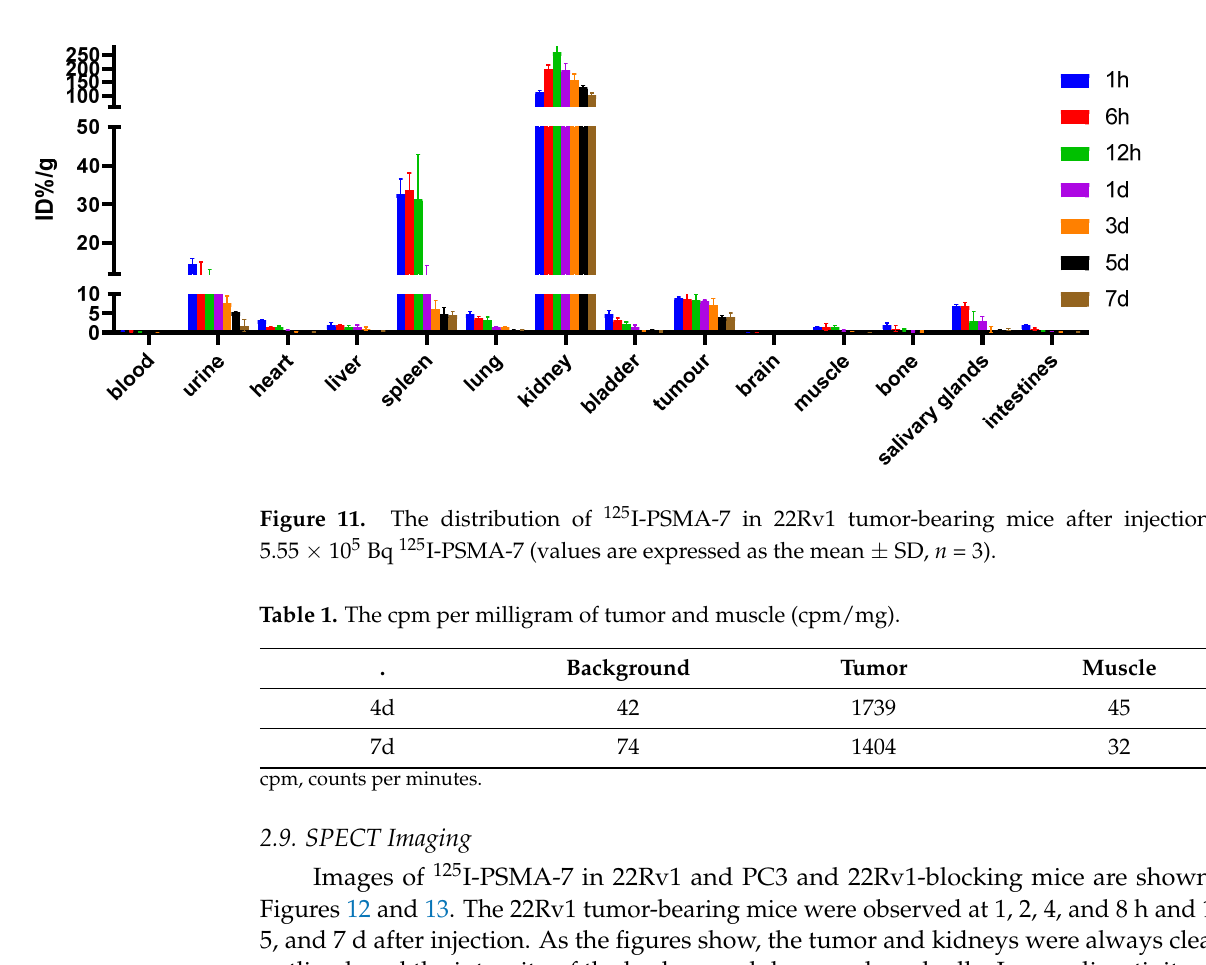
Figure 10. Time–activity curves for blood samples.